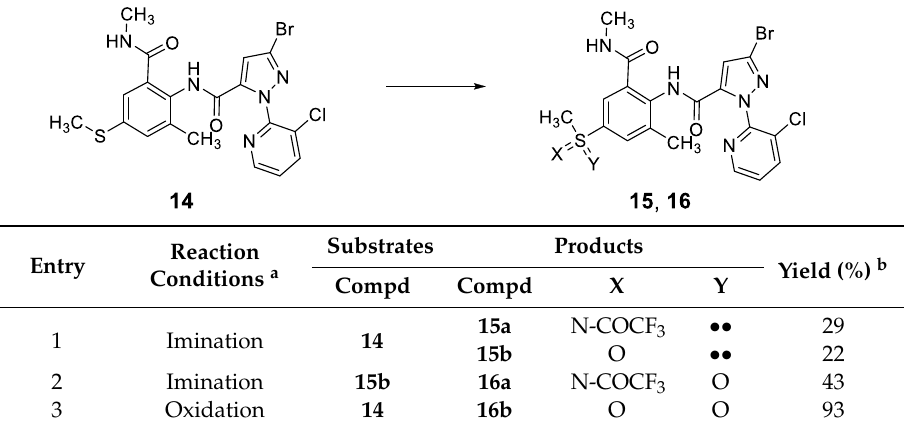
Table 1. Synthesis of aryl organosulfur analogs of diamide insecticides